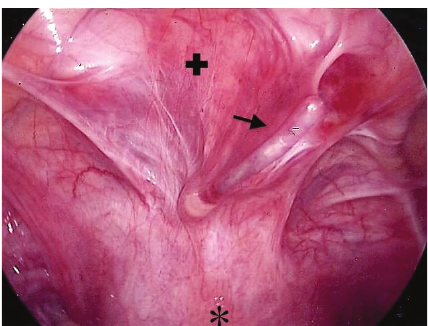
Figure 2: Laparoscopic view of the stylet (black Arrow) placed through the false tract below the bladder (plus symbol) and above the uterus